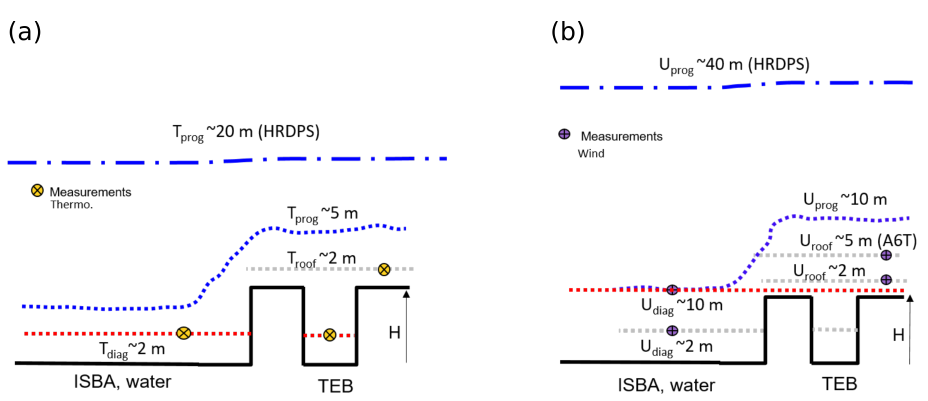
Figure 5. Sketch of the levels for measurements and for references in NWP systems (TOR-GEM250 and HRDPS), for thermodynamic variables ( a ), and wind speed and direction ( b ). GEM prognostic levels in HRDPS (blue dash-dot lines) and TOR-GEM250 (blue dotted line). Reference diagnostic levels (red dotted lines), and additional diagnostic levels corresponding to measurement heights (gray dotted lines). H is for the building